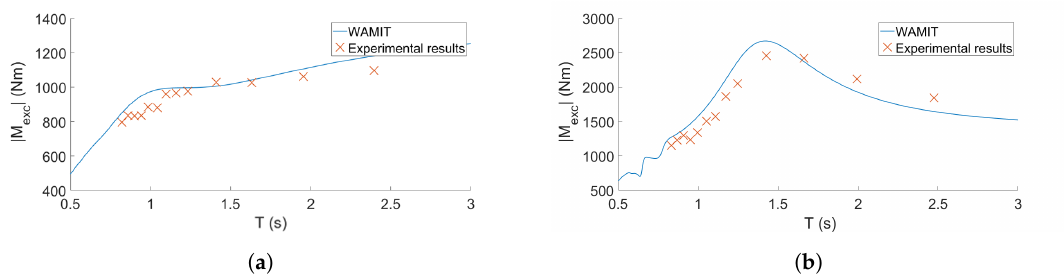
Figure 21. Example of comparison between test results and numerical estimates of excitation moment in pitch using WAMIT. ( a ) Results for Setup WEC Only. ( b ) Results for Setup